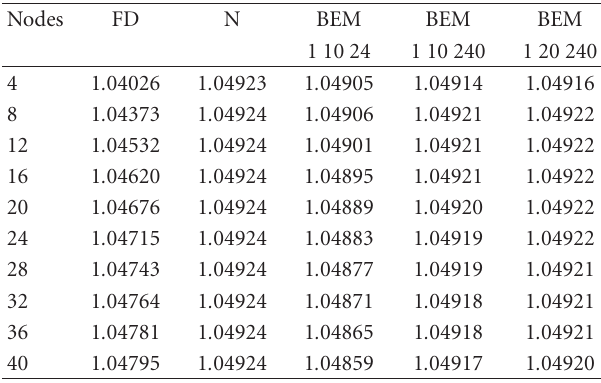
Table 4: Results for the calculation of k for the reflected system.